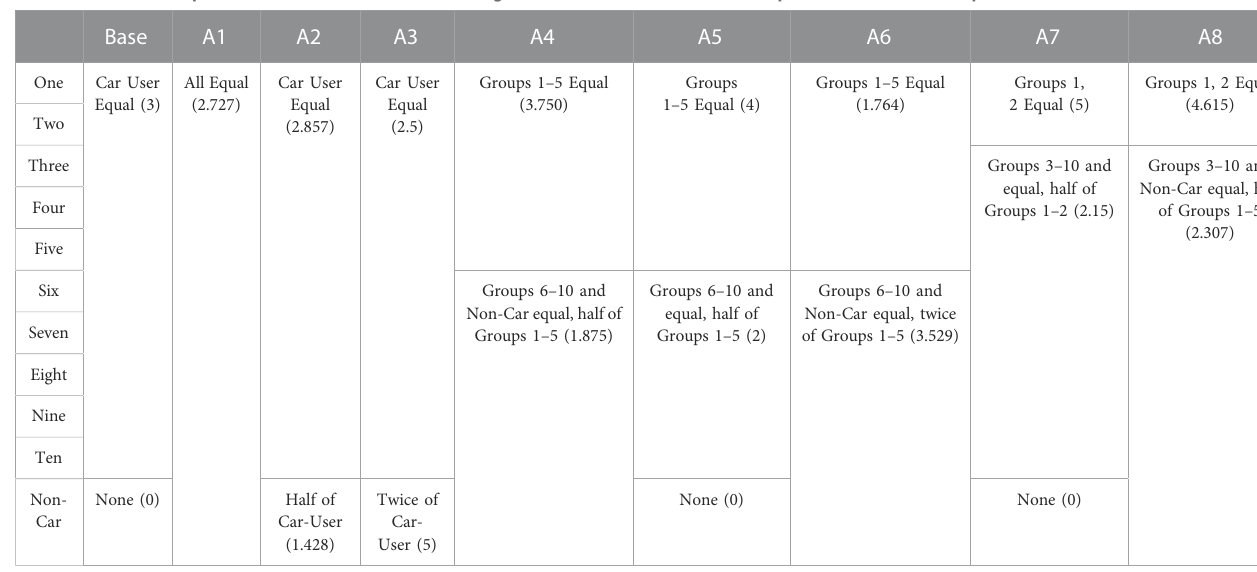
TABLE 3 Allocation of permits to non-car users and according to need (Individual share of total permits with number of permits in